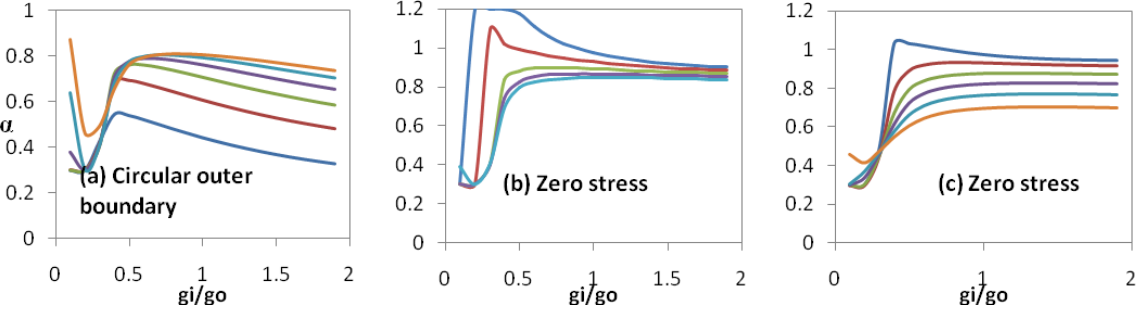
Figure 9: Invariant of two-layer model(inner layer anisotropic). Critical buckling strain at the inner radius α as a function of growth rate ratio between inner and outer layer(isotropic growth in each layer). µ i =40kPa; µ o =8kPa; k 1 =1; k 2 =0.2. 𝛾 = π /6(results for π /4 and π /3 are very similar, not shown). (a) Circular outer boundary. A=1.0, B=1.1, C=1.5. (b) Zero normal and shear stress. A=1.0, B=1.1, C=1.5. (c) Zero normal and shear stress. A=1.0, B=1.2,